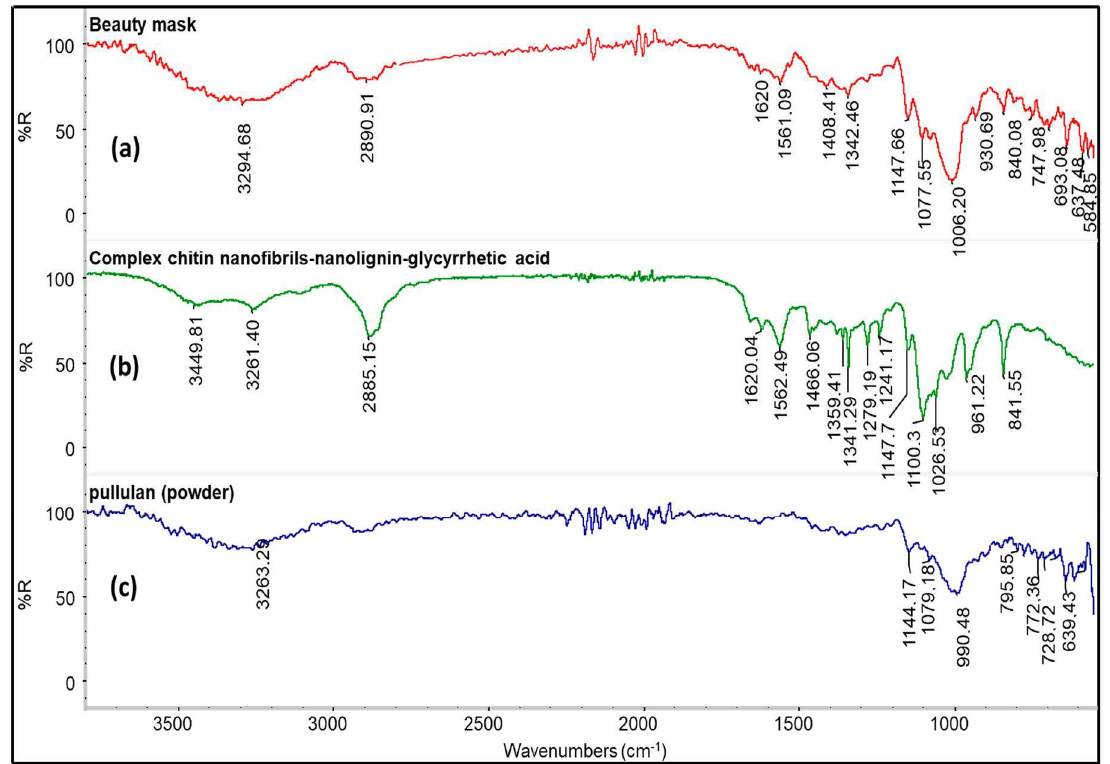
Figure 7. ATR-FTIR spectra of ( a ) pullulan / CLA (i.e., beauty mask); ( b ) CLA complex; ( c ) pure pullulan powder. [CLA stands for CN-NL-GA].